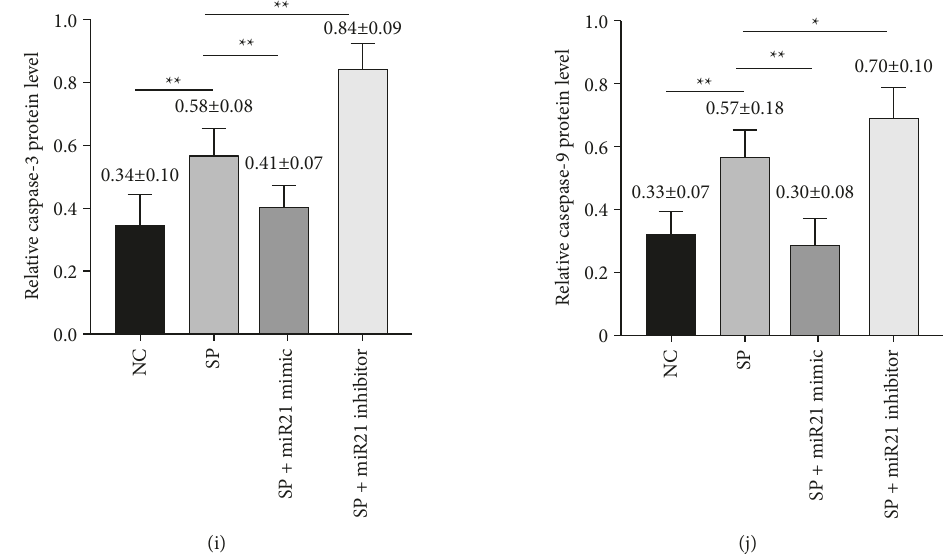
Figure 7: The levels of caspase-3 and caspase-9 in lymphocytes were changed after transfection of miR-21 activator or inhibitor into lymphocytes of septic rats. ((a) and (b)) The relative expressions of caspase-3 and caspase-9 mRNA in eight-paired NC rat group, SP rat group, SP rat+ miR21 mimic group, and SP rat +miR21 inhibitor group were determined by real-time quantitative PCR [ t value (caspase-3: NC versus SP) � 25.960, p < 0.01; t value (caspase-3: miR-21 mimic versus SP) � 10.874, p < 0.01; t value (caspase-3: miR-21 inhibitor versus SP) � 5.934, p < 0.01; t value (caspase-9: NC versus SP) � 13.300, p < 0.01; t value (caspase-9: miR-21 mimic versus SP) � 3.711, p < 0.01; t value (caspase-9: miR-21 inhibitor versus SP) � 12.930, p < 0.01]. ((c) and (d)) The expressions of caspase-3 and caspase-9 protein in eight- paired NC rat group, SP rat group, SP rat+ miR21 mimic group, and SP rat +miR21 inhibitor group were determined by immunoflu- orescence microscope. ((e)–(g)) In in vivo experiments, the protein levels of caspase-3 and caspase-9 in eight-paired NC rat group, SP rat group, SP rat +miR21 mimic group, and SP rat+ miR21 inhibitor group were determined by Western blot [ t value (caspase-3: NC